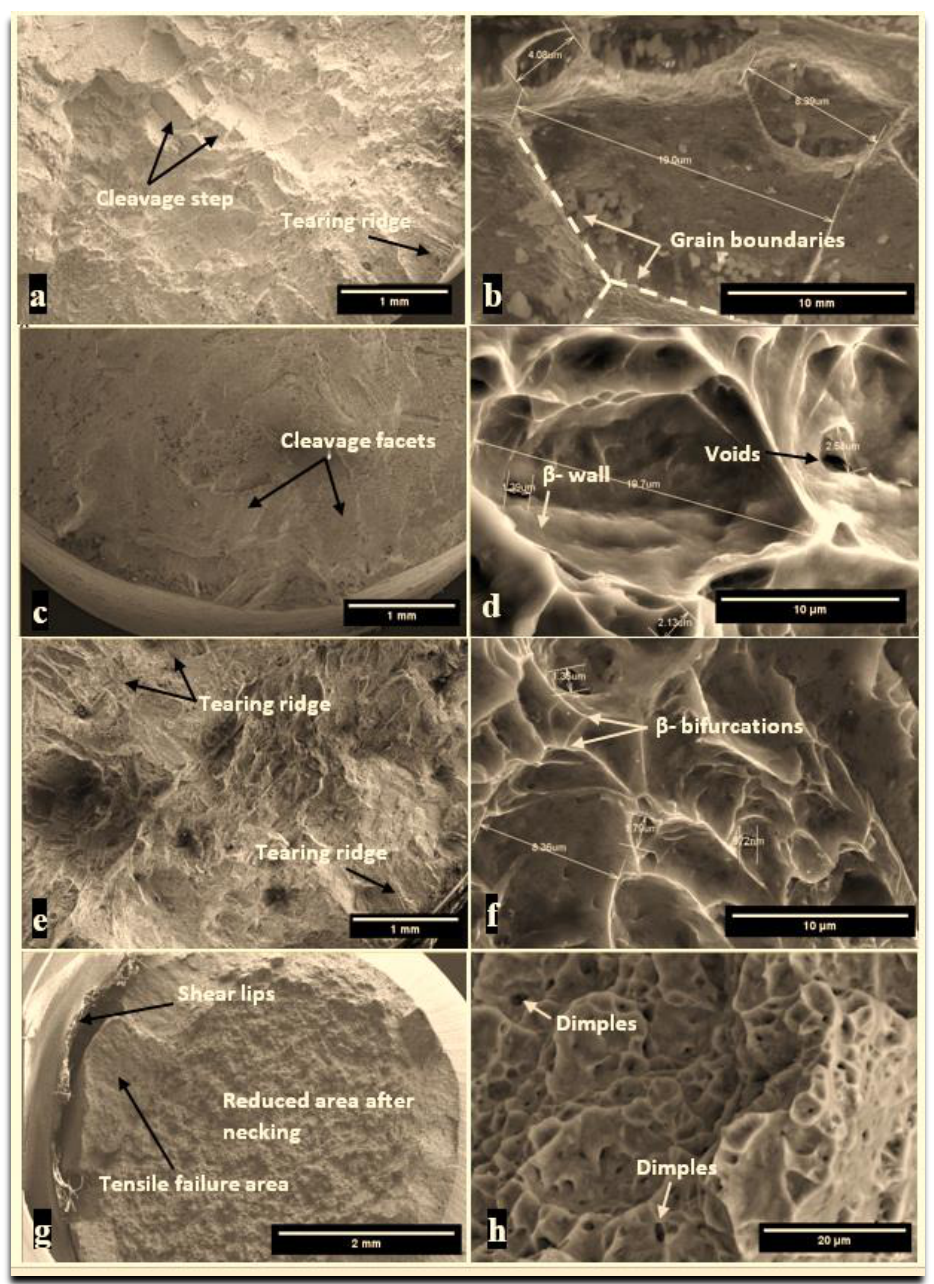
Figure 8. SEM microstructure of fractured surfaces of quenched samples in: oven ( a , b ), water ( c , d ), oil ( e , f ), and without thermal treatment ( g , h